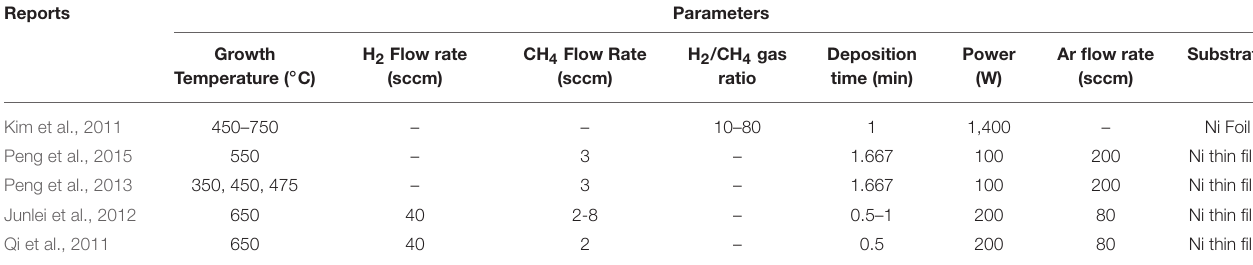
TABLE 2 | Summary of Reported Works with different recipes for PECVD graphene growth on Ni